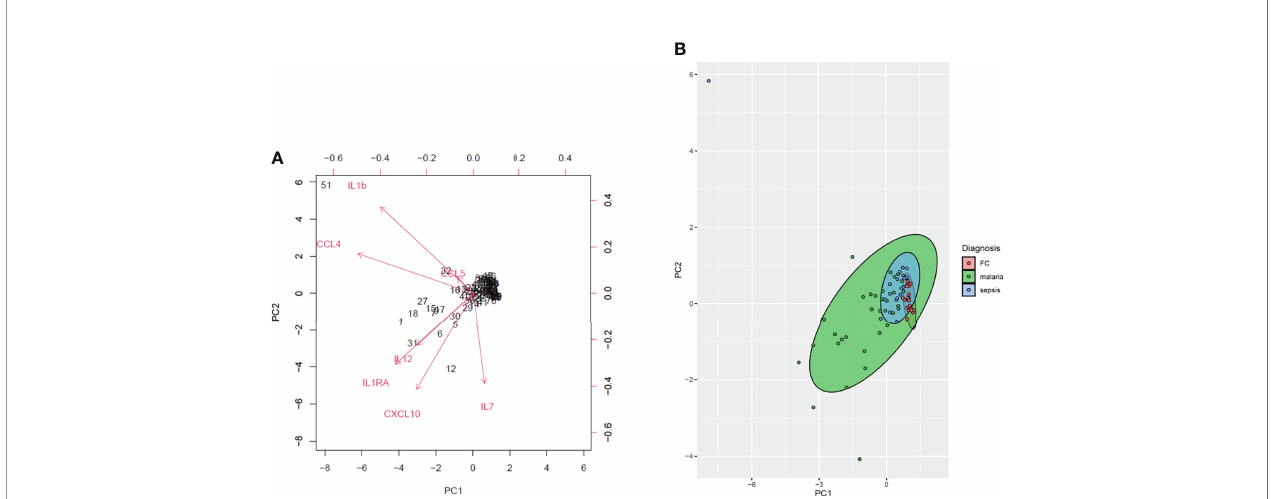
FIGURE 5 | A principal component analysis (PCA) of the plasma cytokines and chemokines measured in the sepsis (n=23), malaria (n=32) and febrile controls (n=30). (A) The biplot depicts the principal components of the immune parameters. The PCA plot shows the levels of the measured plasma cytokines and chemokines (IL-1 b , IL-7, IL-12, IL-1RA, and RANTES/CCL5, MIP1B/CCL4, IP10/CXCL10). The angles between the variables indicate the level of correlation whilst the lengths of the arrows show the variance. (B) The green, blue and red symbols represent the malaria, sepsis and febrile controls respectively whereas the corresponding ellipses represent the clusters of the various populations